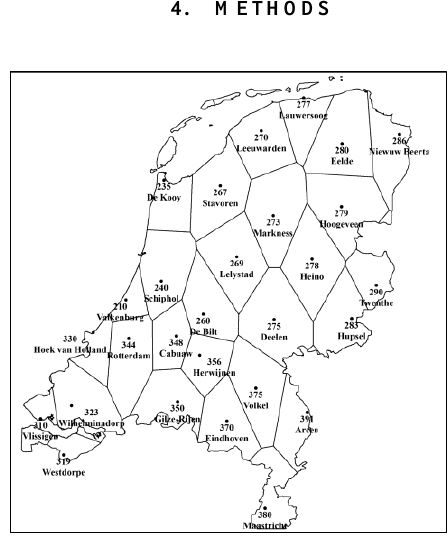
Figure 1. Thiessen polygon map of the Dutch weather stations.